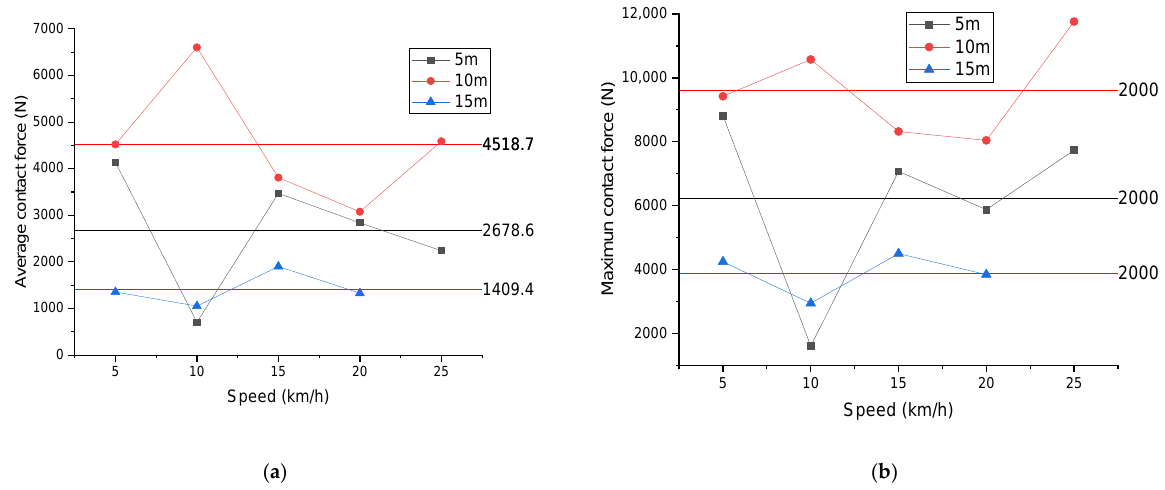
Figure 16. Relationship between vehicle speed and contact force. ( a ) Relationship between average contact force and vehicle speed, ( b ) Relationship between maximum contact force and vehicle speed.